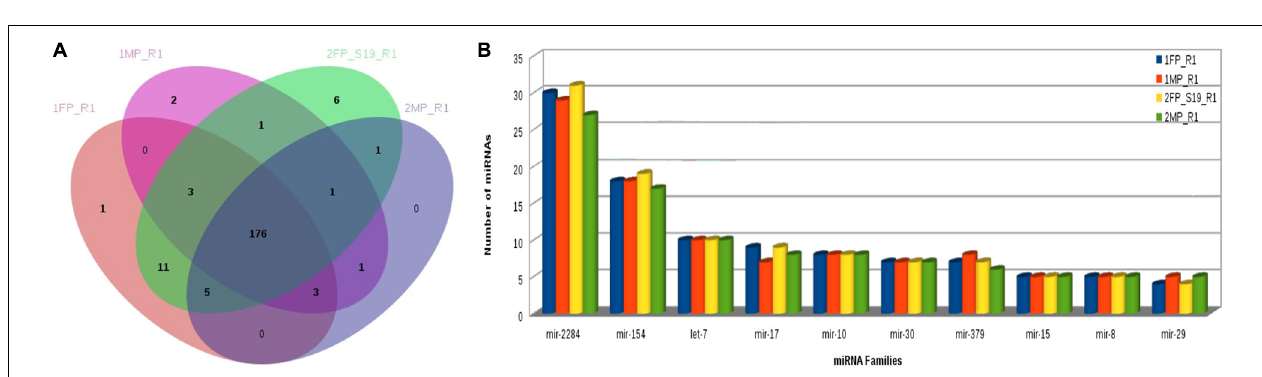
FIGURE 8 | (A) Known microRNA: Gene Ontology categories for biological processes, cellular component, and molecular function enriched across the target genes of differentially expressed known microRNA. (B) Pathway distribution in known miRNA. (C) Novel microRNA: Gene Ontology categories for biological processes, cellular component, and molecular function enriched across the target genes of differentially expressed novel microRNA. (D) Pathway distribution in novel miRNA [1FP_R1, early-stage fetal placentome (cotyledon); 1MP_R1, early-stage maternal placentome (caruncle); 2FP_S19_R1, mid-stage fetal placentome (cotyledon); 2MP_R1, mid-stage maternal placentome (caruncle)].